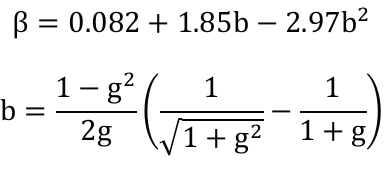
Table 2. Aerosol optical properties obtained during the study.